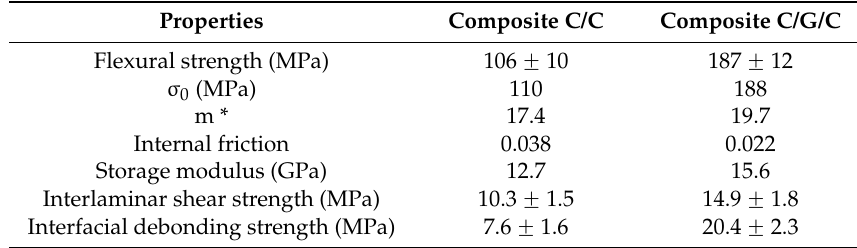
Table 2. Static mechanical performance results and dynamic mechanical properties of the composites at 50 °C, 10 Hz, and 0.025% strain.